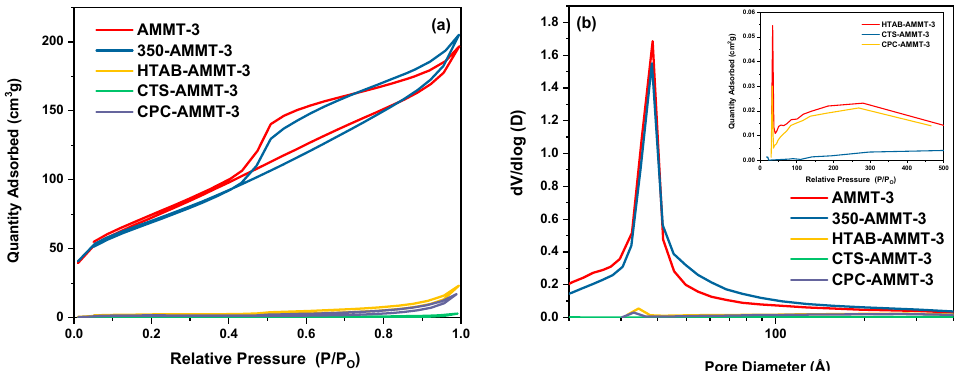
Figure 2 . N 2 adsorption–desorption isotherms ( a ) and pore size distribution ( b ) of the modified montmorillonites. Table 4 . Texture properties of the modified montmorillonites.